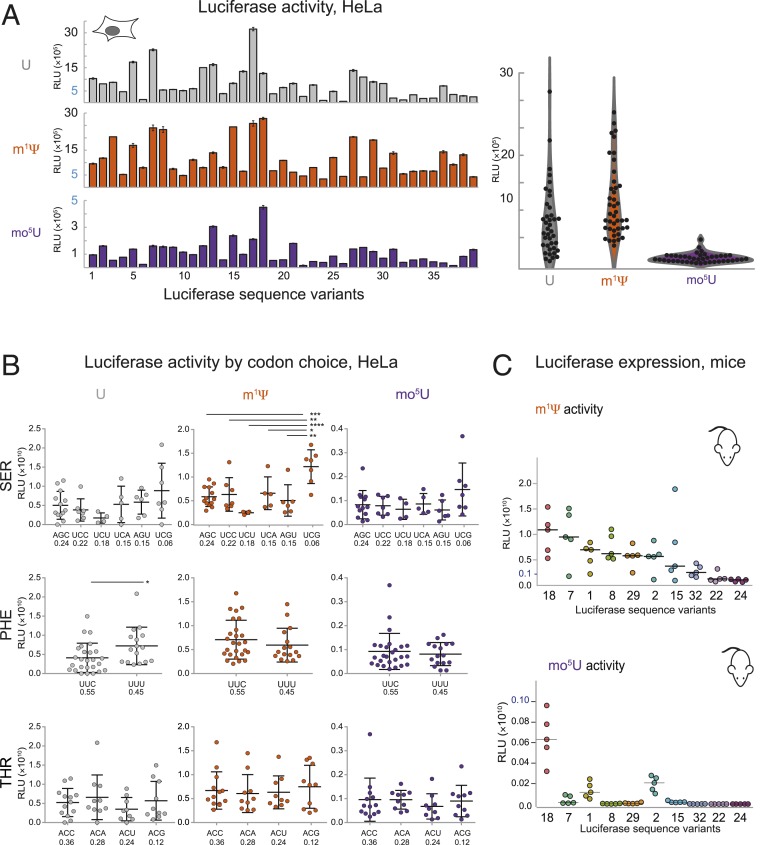
Inclusion of modified nucleotides in mRNA alters Luc expression. (A, Left) Expression in HeLa cells (relative light units [RLU], y axis) for 39 firefly Luciferase sequence variants (L1–L39, x axis) containing uridine (gray, Top), m1Ψ (orange, Middle), or mo5U (dark purple, Bottom). (A, Right) Distribution of expression levels (RLU, y axis) for variants (black dots) containing uridine (gray), m1Ψ (orange), and mo5U (dark purple) as a violin plot. (B) Expression in HeLa cells (RLU, y axis) of 39 firefly Luciferase variants grouped by the codon used (x axis) for all instances of serine (Top), phenylalanine (Middle), and threonine (Bottom) in mRNAs containing uridine (Left), m1Ψ (Middle), or mo5U (Right). Codons are shown in order of frequency of occurrence in the human transcriptome. Individual values (dots) are the same as in A with mean and SEs (black lines). Significant differences by 2-way ANOVA comparisons are indicated by lines above, and P values are noted by asterisks (*P ≤ 0.05, **P ≤ 0.01, ***P ≤ 0.001, and ****P ≤ 0.0001). (C) Total luminescence of in vivo firefly Luciferase expression (RLU, y axis) in CD-1 mice (5 per group) following IV injection of 0.15 mg/kg LNP-formulated mRNA for 10 sequence variants (x axis) containing m1Ψ (Top) or mo5U (Bottom). Individual animals (dots) with median.